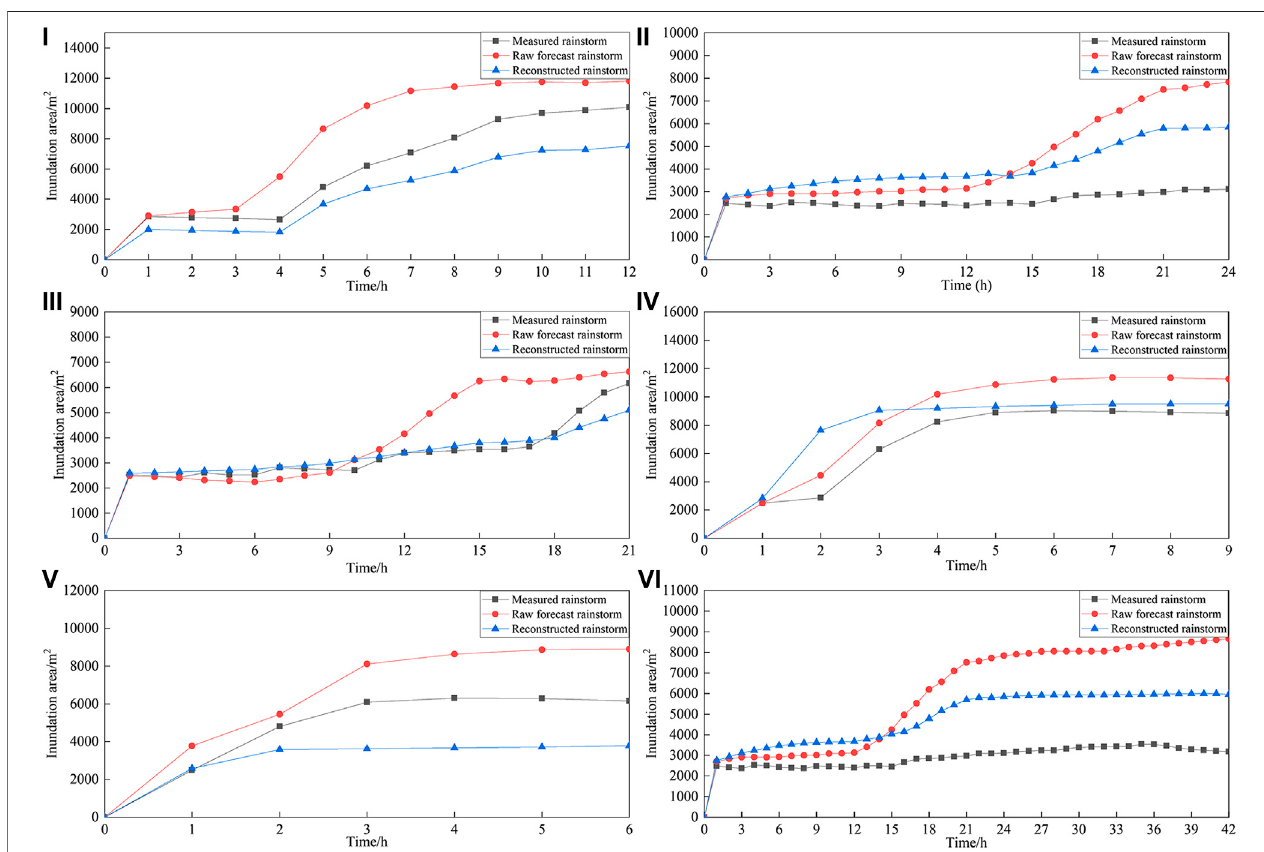
FIGURE 7 | Inundation area simulation by using different input data: the labels “ I-VI ” represent the serial number of six rainstorms; the black line is the simulated inundation area generated by using measured rainfall data; the red line is the simulated inundation area generated by using the raw GRAPES_MESO forecast data; the blue line is the simulated inundation area generated by using the reconstructed forecast